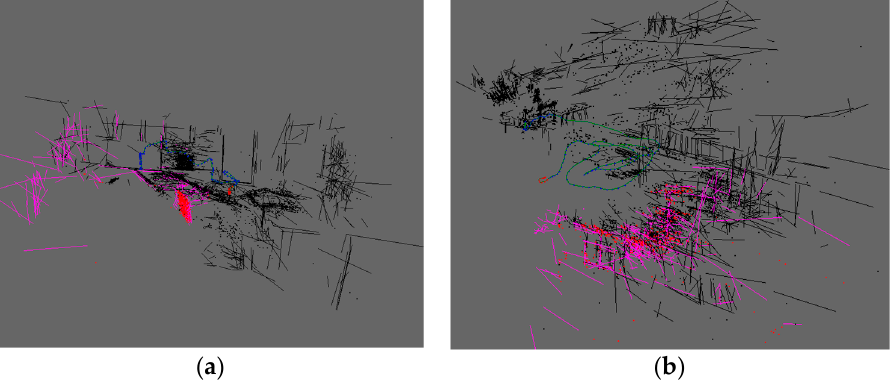
Figure 11. Sparse maps in terms of fused point and line features, ( a ) V1_01_easy sequence; ( b ) MH_04_difficult sequence.